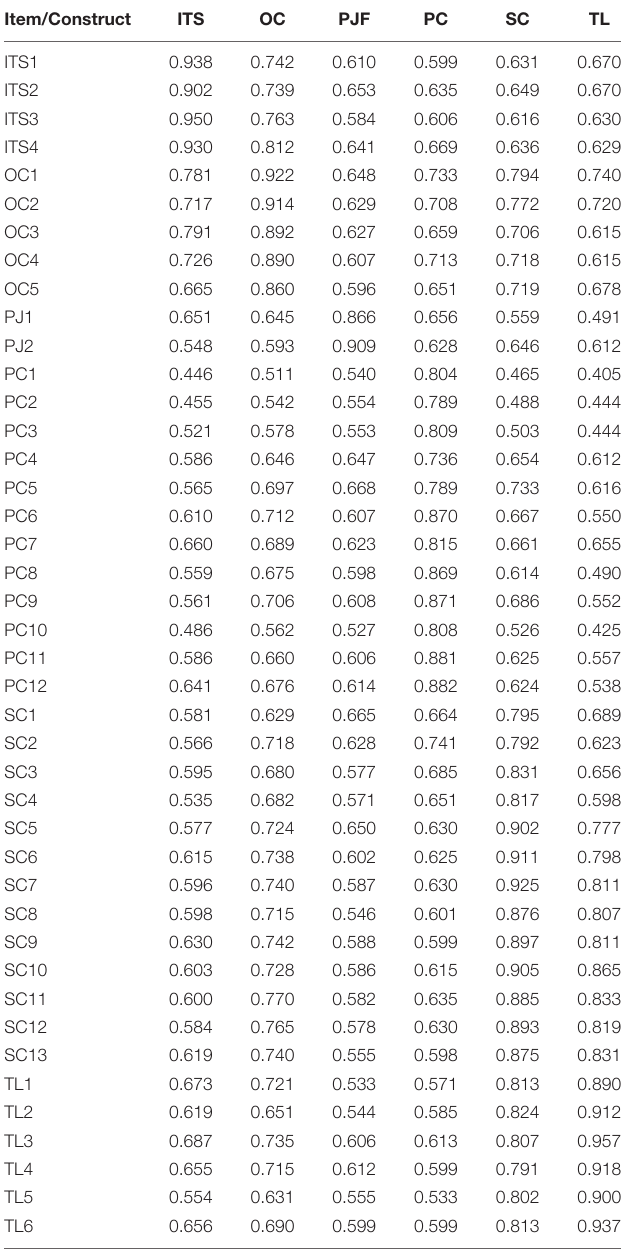
TABLE 2 | Standardized factor loadings and cross-loadings of the outer model.